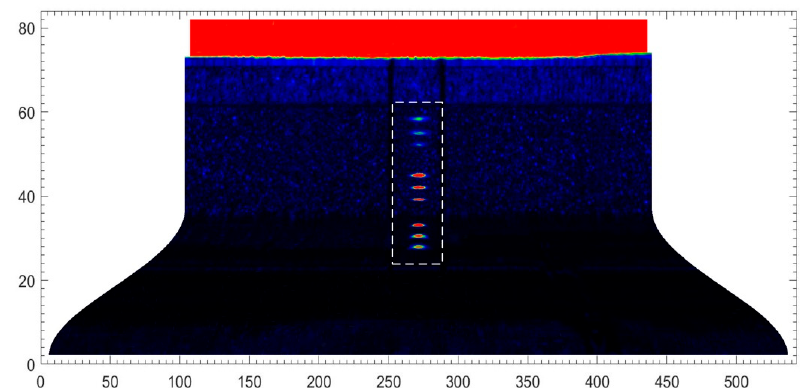
Figure 8. C-scan image of transverse cracks developing when the water path was 91.29 mm.